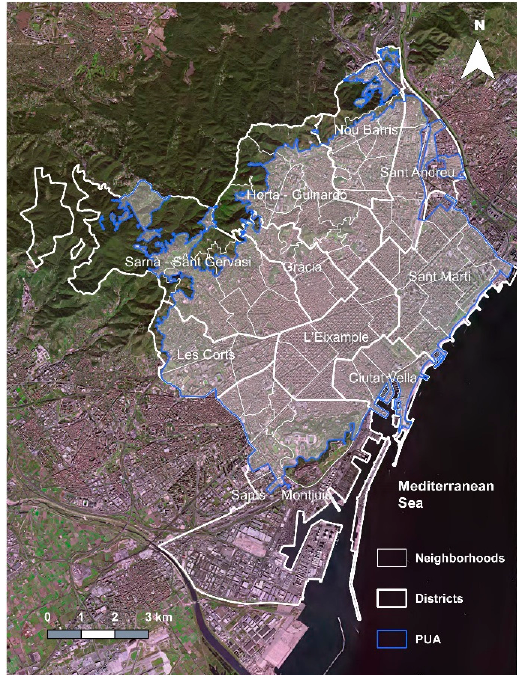
Figure 1. Territorial delimitations in Barcelona. Source: [3].